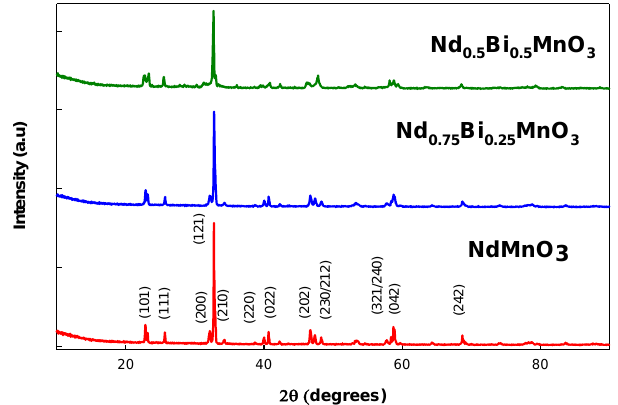
Figure 1. X-ray diffraction of Nd 1−x Bi x MnO 3 (x = 0, 0.25 and 0.50) samples. Figure 1. X-ray di ff raction of Nd 1 − x Bi x MnO 3 (x = 0, 0.25 and 0.50) samples. Crystals 2020 , 10 , x FOR PEER REVIEW